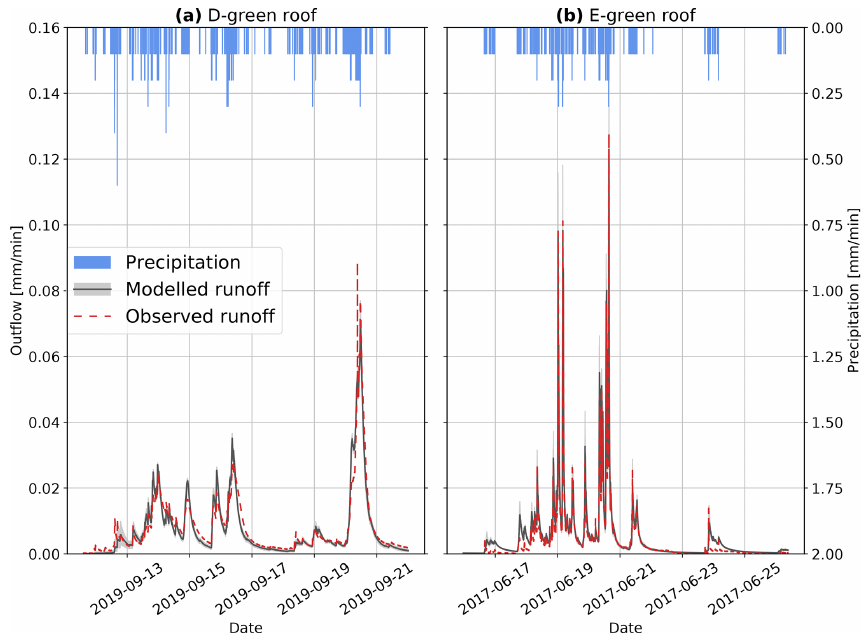
Figure 2. Testing of the green roof’s reservoir model. Observed and modelled runoff of the detention-based extensive green roof (D) model on 10-day period (a) and extensive green roof (E) for a period of 8d (b) in Trondheim.